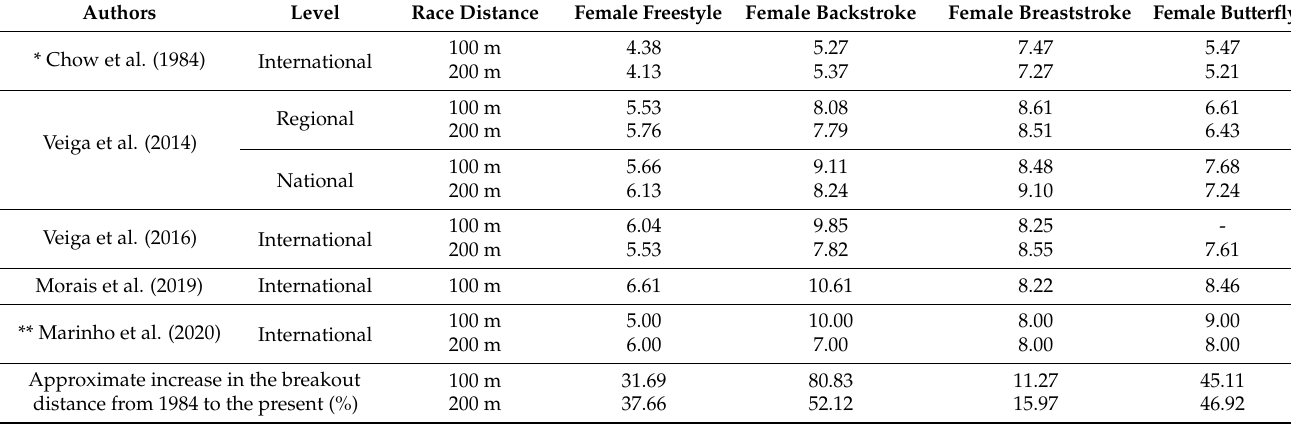
Table 5. Breakout distance after the turn in the four swimming strokes in 1984 and recent years in female events (the numbers in the table only show the mean value presented in each